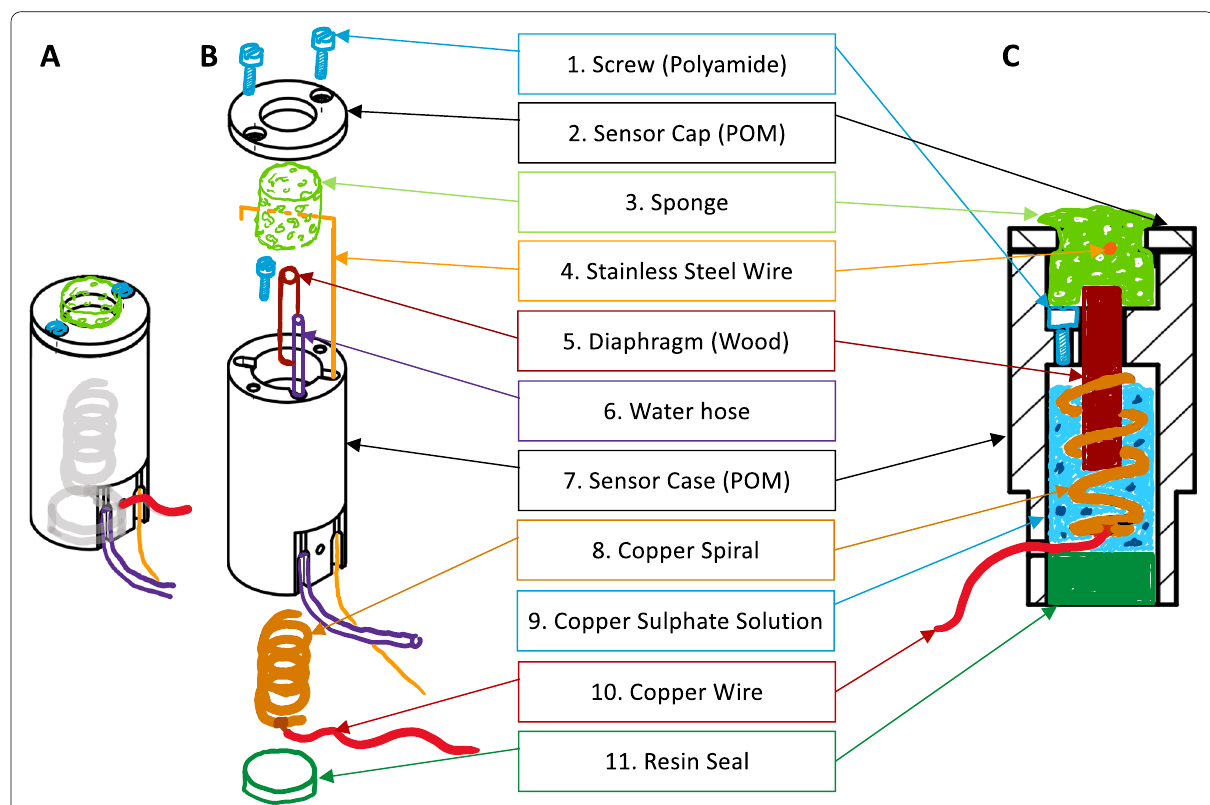
Fig. 5 Design of the copper/copper sulfate reference electrode for non-sight measurements underground with named parts. A : Fully assembled, B : Exploded view, and C : Sectional